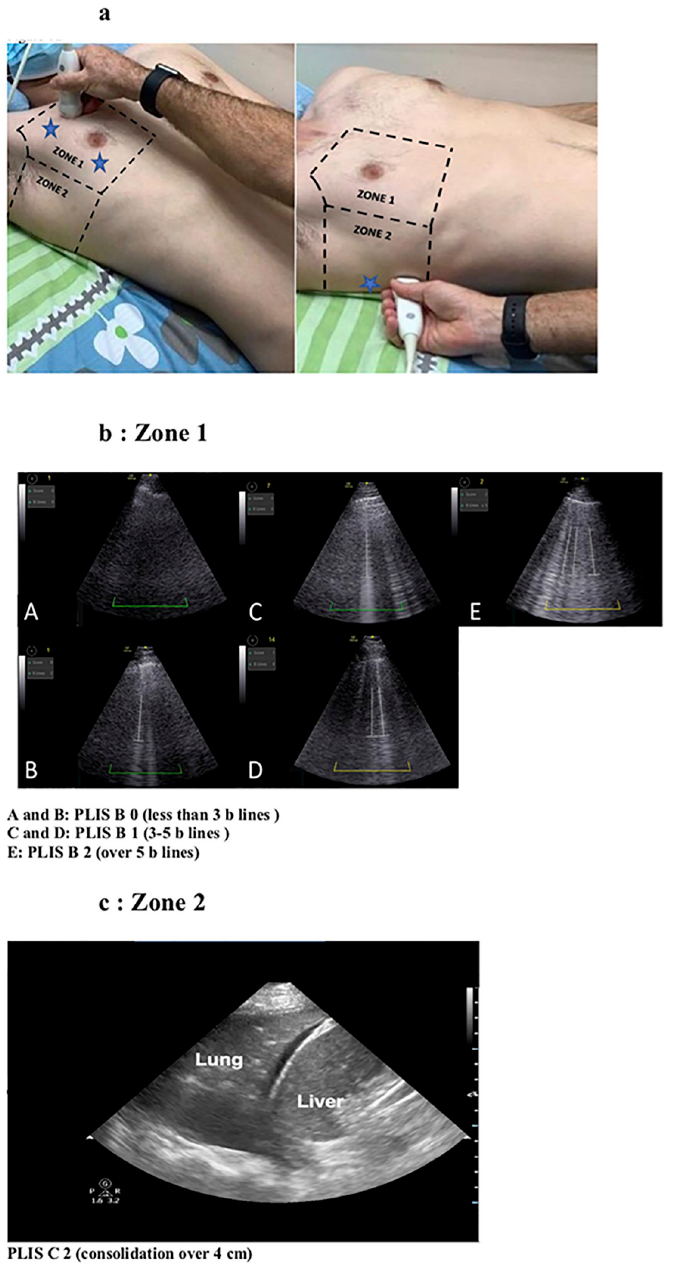
Fig 1. a. Lung zones: The three scanning areas are marked with blue stars. b. Zone 1, PLIS B, c . Zone 2, PLIS C. The stars represent the area of the scan in each zone and not the exact place of the